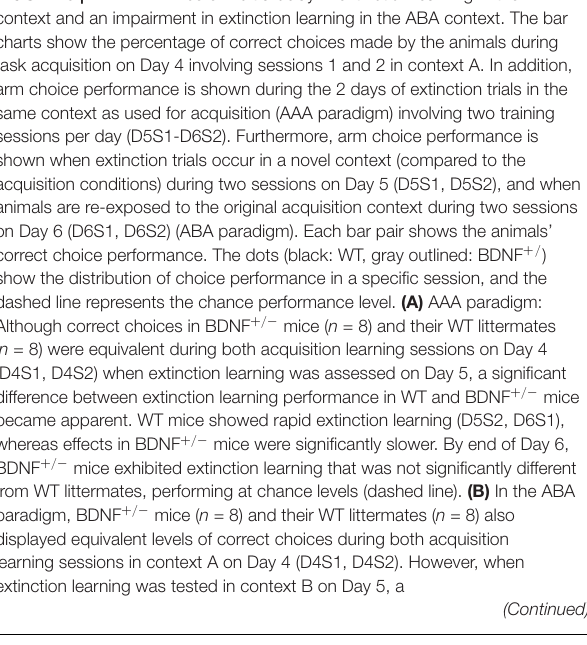
FIGURE 3 | BDNF + / − mice exhibit a delay in extinction learning in the AAA context and an impairment in extinction learning in the ABA context. The bar charts show the percentage of correct choices made by the animals during task acquisition on Day 4 involving sessions 1 and 2 in context A. In addition, arm choice performance is shown during the 2 days of extinction trials in the same context as used for acquisition (AAA paradigm) involving two training sessions per day (D5S1-D6S2). Furthermore, arm choice performance is shown when extinction trials occur in a novel context (compared to the acquisition conditions) during two sessions on Day 5 (D5S1, D5S2), and when animals are re-exposed to the original acquisition context during two sessions on Day 6 (D6S1, D6S2) (ABA paradigm). Each bar pair shows the animals’ correct choice performance. The dots (black: WT, gray outlined: BDNF + / ) show the distribution of choice performance in a specific session, and the dashed line represents the chance performance level. (A) AAA paradigm: Although correct choices in BDNF + / − mice ( n = 8) and their WT littermates ( n = 8) were equivalent during both acquisition learning sessions on Day 4 (D4S1, D4S2) when extinction learning was assessed on Day 5, a significant difference between extinction learning performance in WT and BDNF + / − mice became apparent. WT mice showed rapid extinction learning (D5S2, D6S1), whereas effects in BDNF + / − mice were significantly slower. By end of Day 6, BDNF + / − mice exhibited extinction learning that was not significantly different from WT littermates, performing at chance levels (dashed line). (B) In the ABA paradigm, BDNF + / − mice ( n = 8) and their WT littermates ( n = 8) also displayed equivalent levels of correct choices during both acquisition learning sessions in context A on Day 4 (D4S1, D4S2). However, when